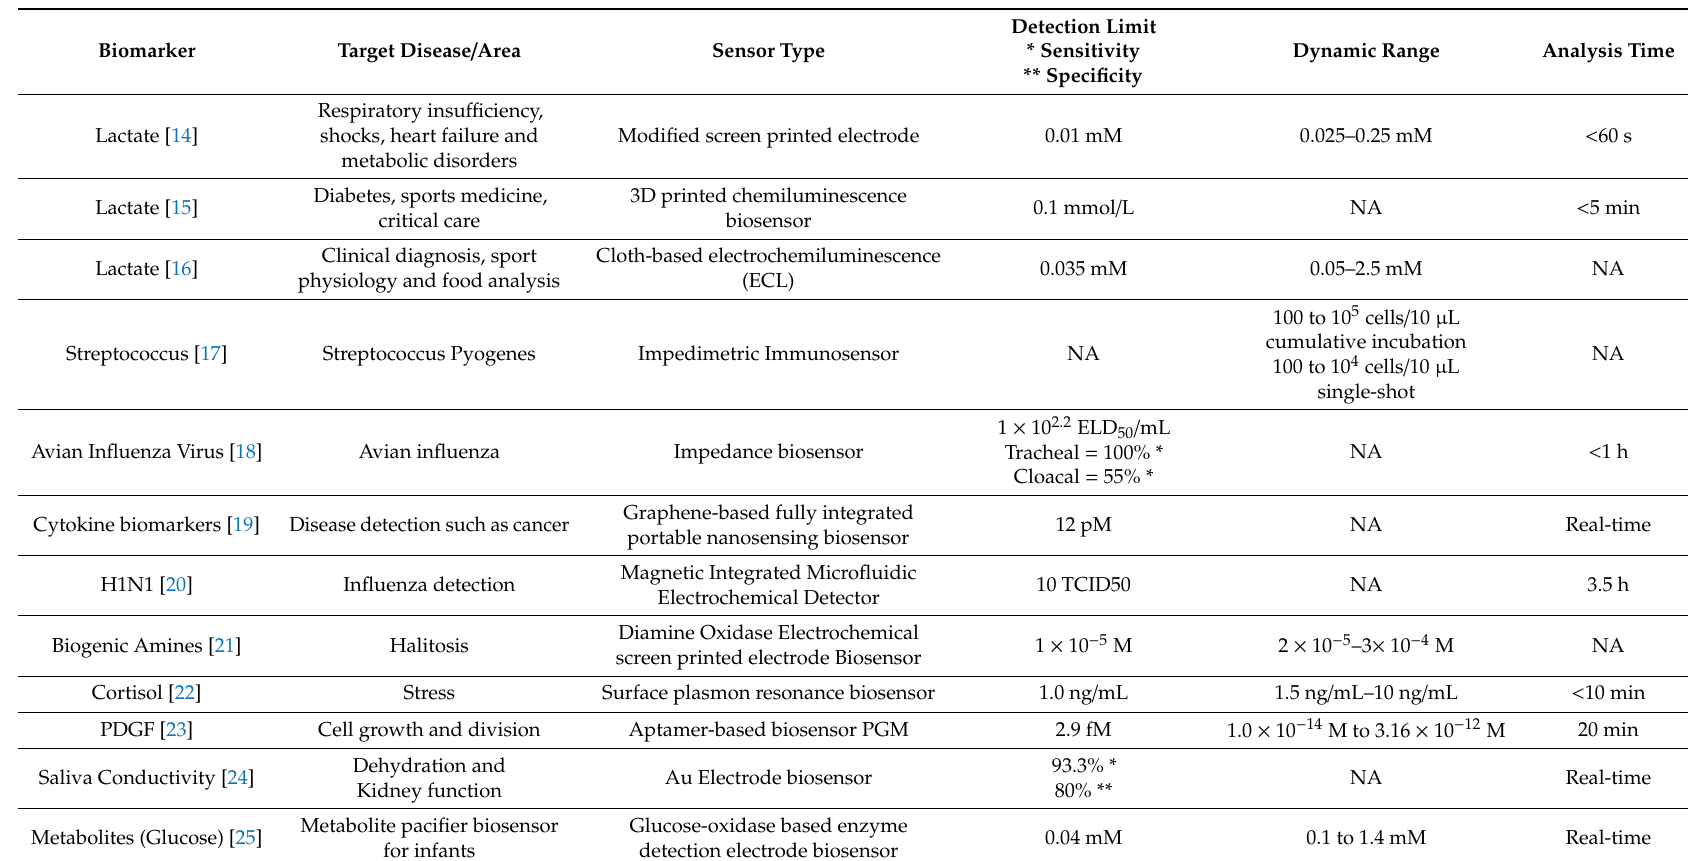
Table 1. Summary of Portable Biosensors for Salivary Biomarker